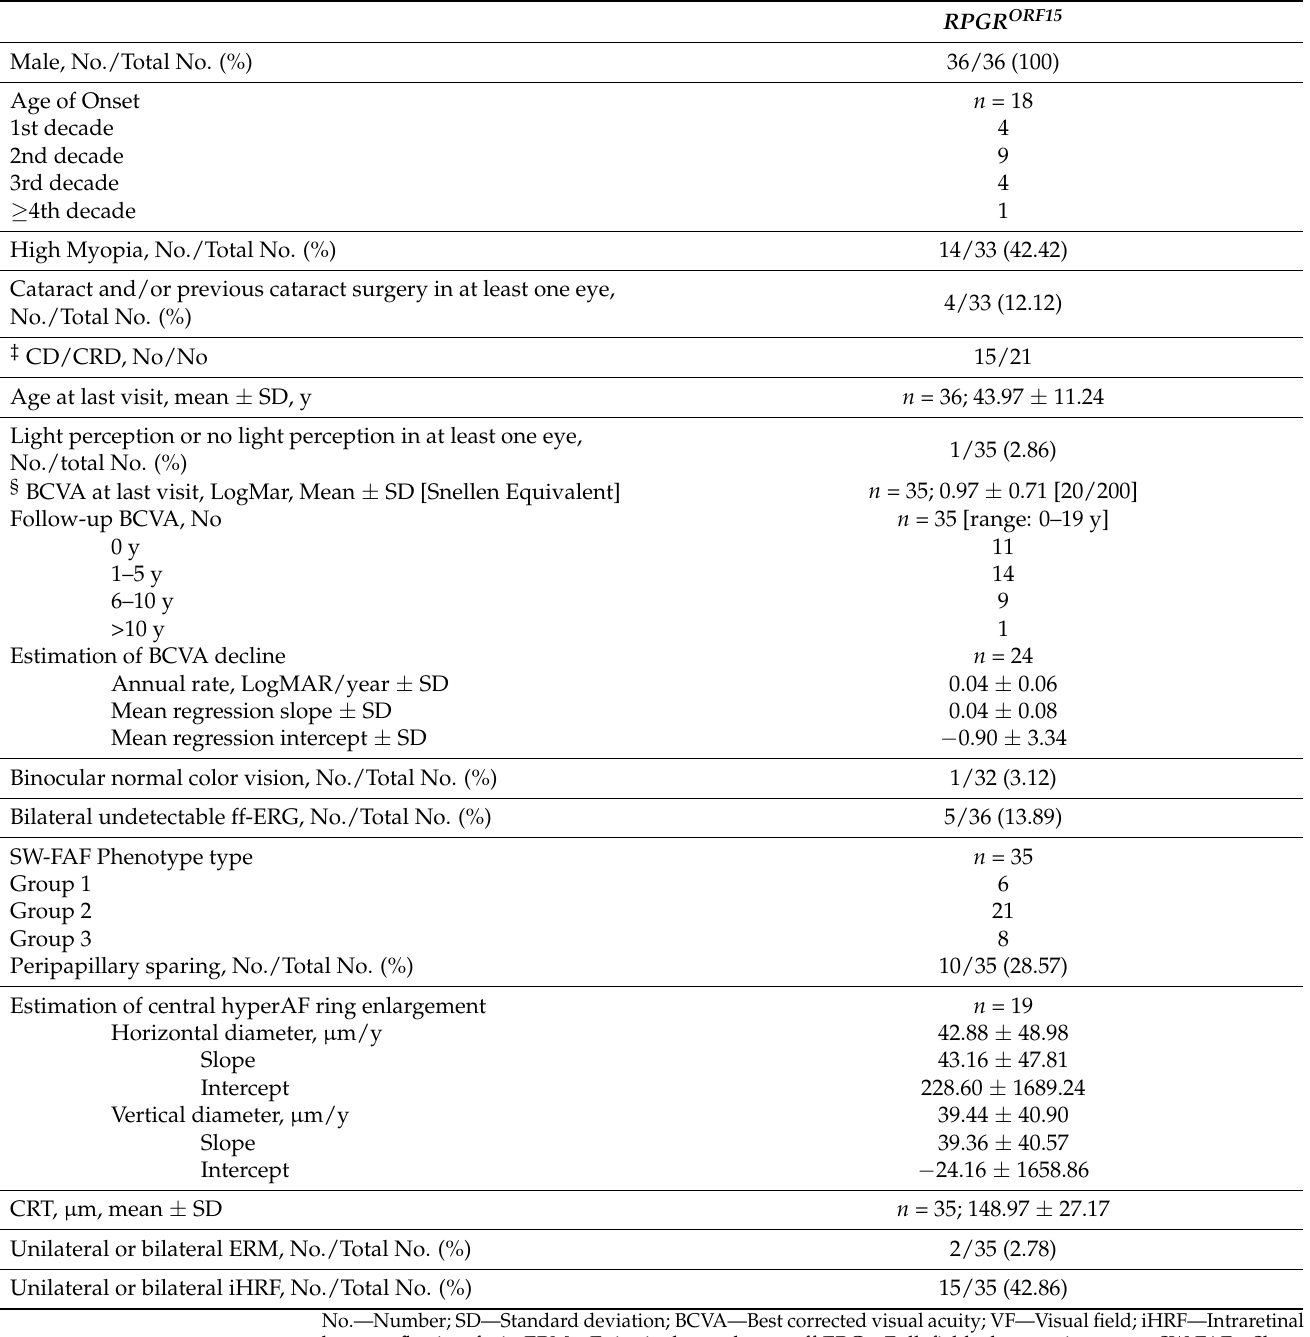
Table 3. The results of the data analysis on patients with cone/cone-dystrophy (CDs/CRDs) included in the study.